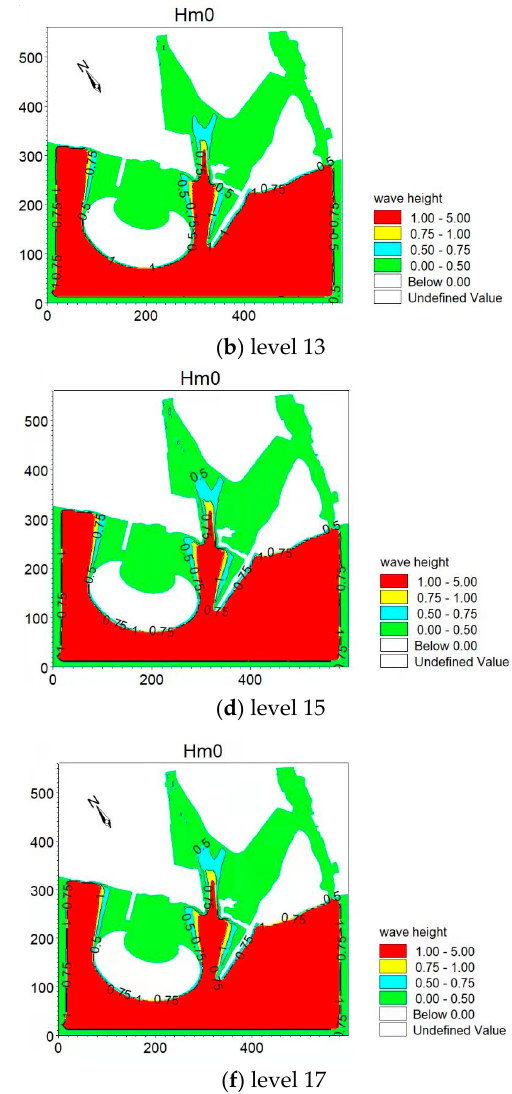
Table 2. Total number of vessels that can be berthed in SYFP during level 12–17 typhoons.